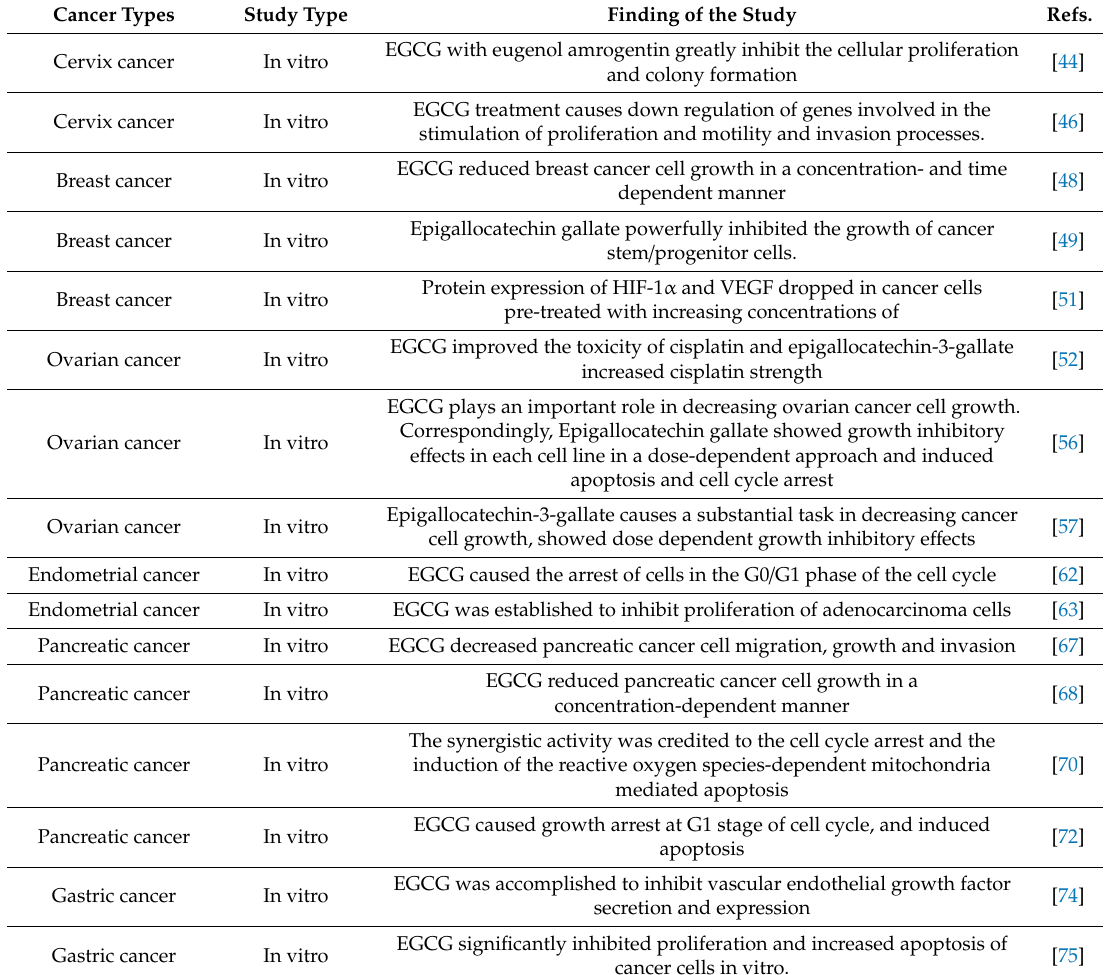
Table 2. Role of EGCG in cancer prevention through based on in vitro